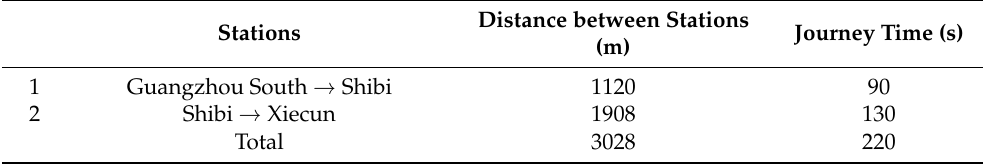
Table 4. Scheduled information of railway vehicle [17].